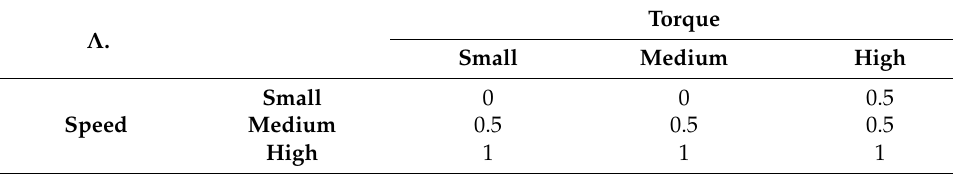
Table 1. Rule table for the fuzzy logic transition. Λ